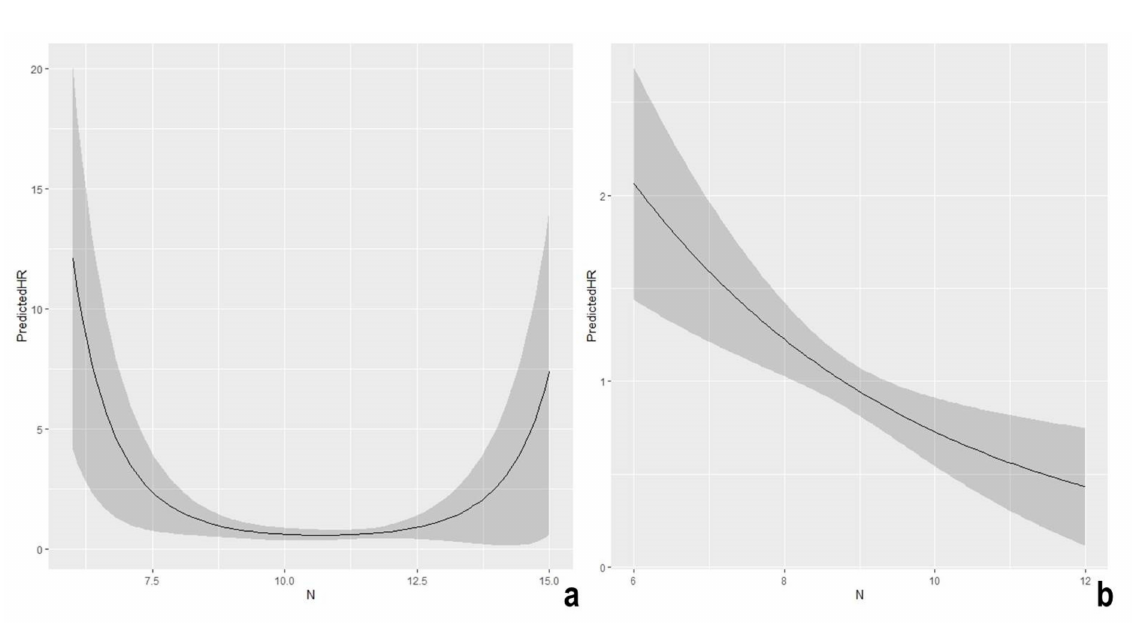
Figure 4. Shape of the predicted Hazard Ratio (HR) as a function of nitrogen isotopic signatures ( δ 15 N) in the Imperial Rome ( a ) and in the Middle Ages ( b ). Sex was set to “males” and carbon values to the median